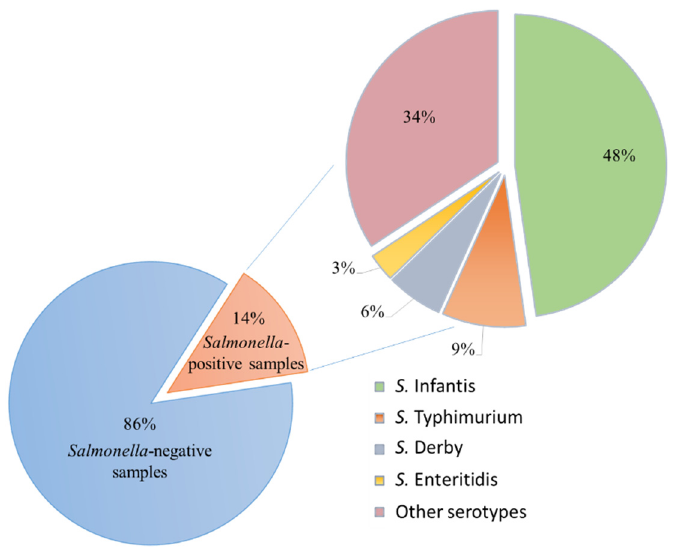
Figure 2. Salmonella spp. research results and serotypes identified in the 2019–2021 three-year period.